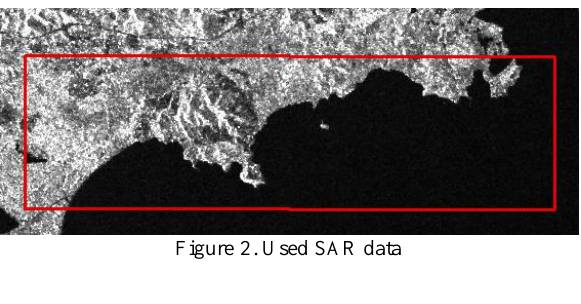
Figure 2. Used SAR data